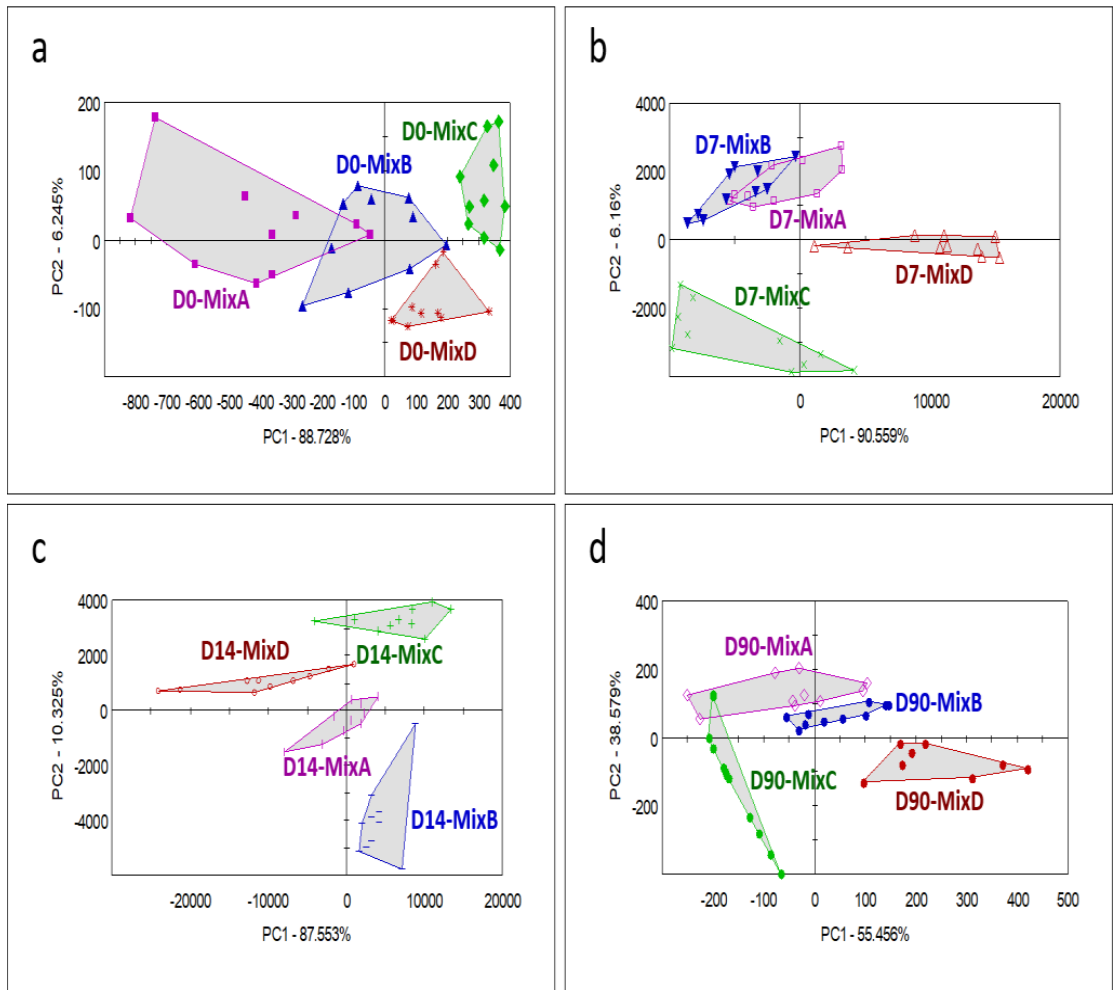
Figure 5. PCA score plots calculated from the aroma profiles of the silages at different fermentation stages ( a ): Day 0; ( b ): Day 7; ( c ): Day 14; ( d ): Day 90, indicating the type of mixture (mixture A, B, C and D) within each plot.